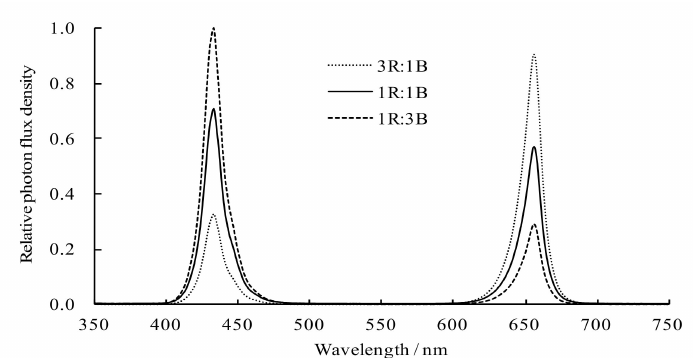
Figure 1. Spectral distribution of LED lights with di ff erent red:blue